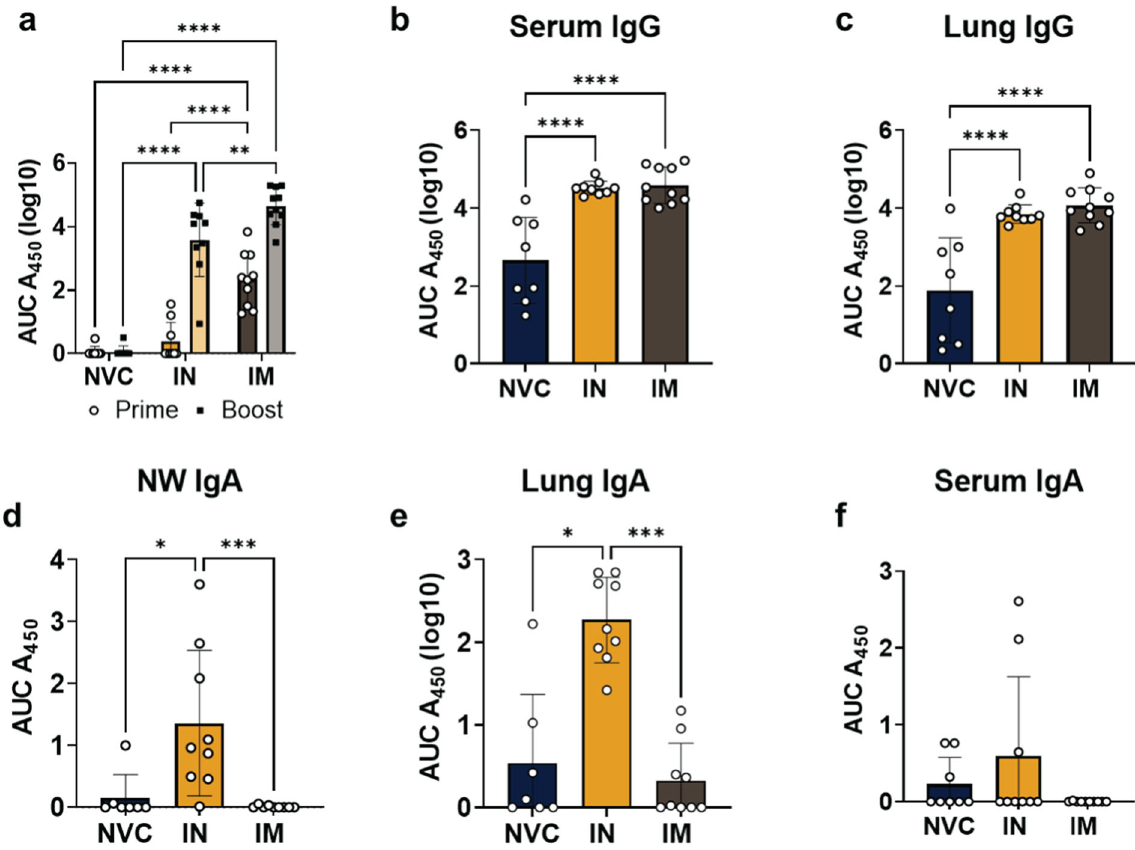
Fig. 5 Serological analysis of serum, lung, and nasal antibodies. RBD IgG and IgA titers represented by log10 AUC450 values. Results represented as mean ± SD. a Pre-challenged NVC, IN and IM RBD IgG titers at 2 weeks post prime (left column, circles) and 2 weeks post boost (right column, squares). Two-way ANOVA with Tukey ’ s multiple comparisons test was used to determine P values. p < 0.0001****, p = 0.0051**. b Serum RBD-IgG titers post challenge. One way ANOVA performed for statistical analysis with Tukey ’ s multiple comparisons test. p < 0.0001****. c Lung supernatant RBD-IgG titers post challenge. One way ANOVA performed for statistical analysis with Tukey ’ s multiple comparisons test. p < 0.0001****. d NW RBD-IgA titers post challenge. Kruskal – Wallis test with Dunn ’ s multiple comparisons test performed for statistical analysis. P = 0.0009***, p < 0.0108*. e Lung supernatant RBD-IgG titers post challenge. Kruskal – Wallis test with Dunn ’ s multiple comparisons test performed for statistical analysis. P = 0.0009***, P = 0.0129*. f Serum RBD-IgA titers post